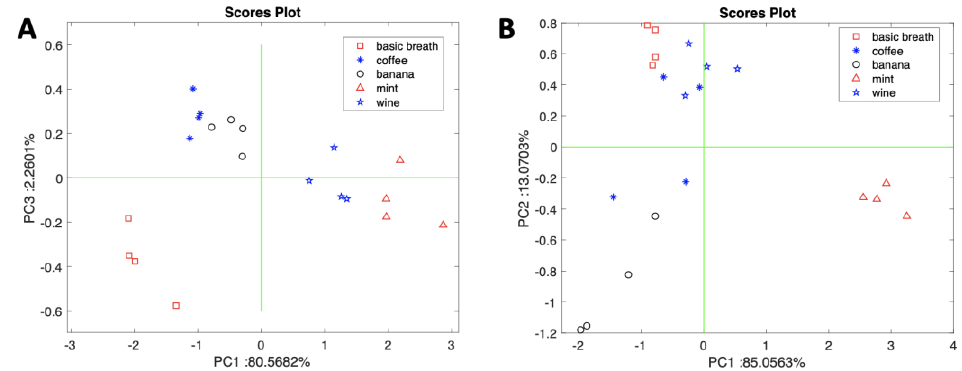
Figure 9. PCA scores plot of features calculated on the slow breath rate signal ( A ) and normal breath rate signals ( B